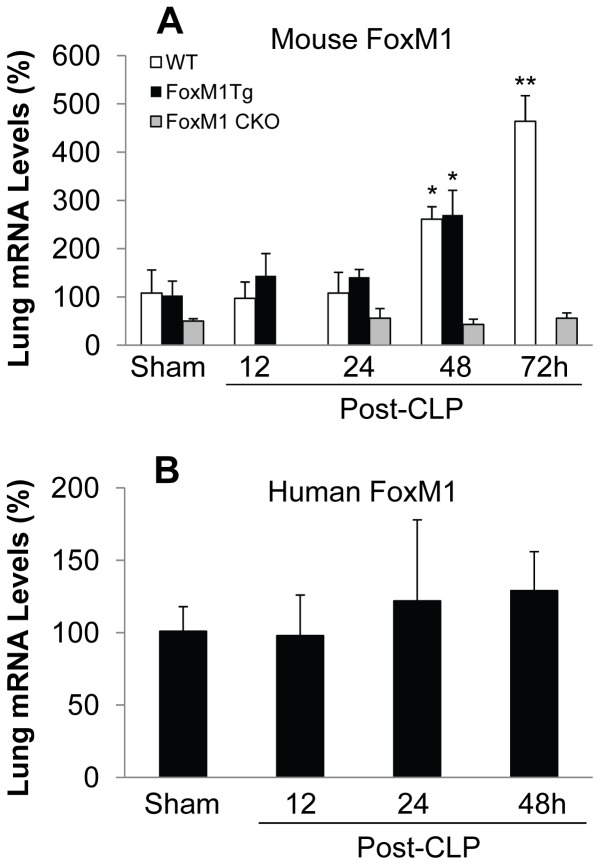
Time course of FoxM1 expression in lungs following CLP challenge.Lung tissues were collected at indicated times post-CLP challenge or 24 h post-sham surgery for RNA isolation and QRT-PCR analysis. Expression of endogenous mouse FoxM1 was assessed with the primers specific with mouse FoxM1 (A) whereas expression of the transgene was analyzed with the primers specific with human FoxM1 (B). Data are expressed as mean ± SD (n = 3–5 per times). *, P<0.01 versus Sham; **, P<0.001. Mouse FoxM1 was similarly induced in WT or FoxM1 Tg lungs following CLP challenge but not in FoxM1 CKO lungs. Human FoxM1 was constitutively expressed in FoxM1 Tg lungs at various times post-CLP.